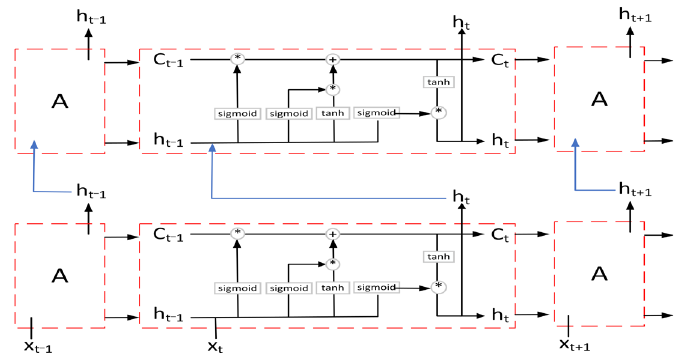
Figure 4. Structure of stacked LSTMs.